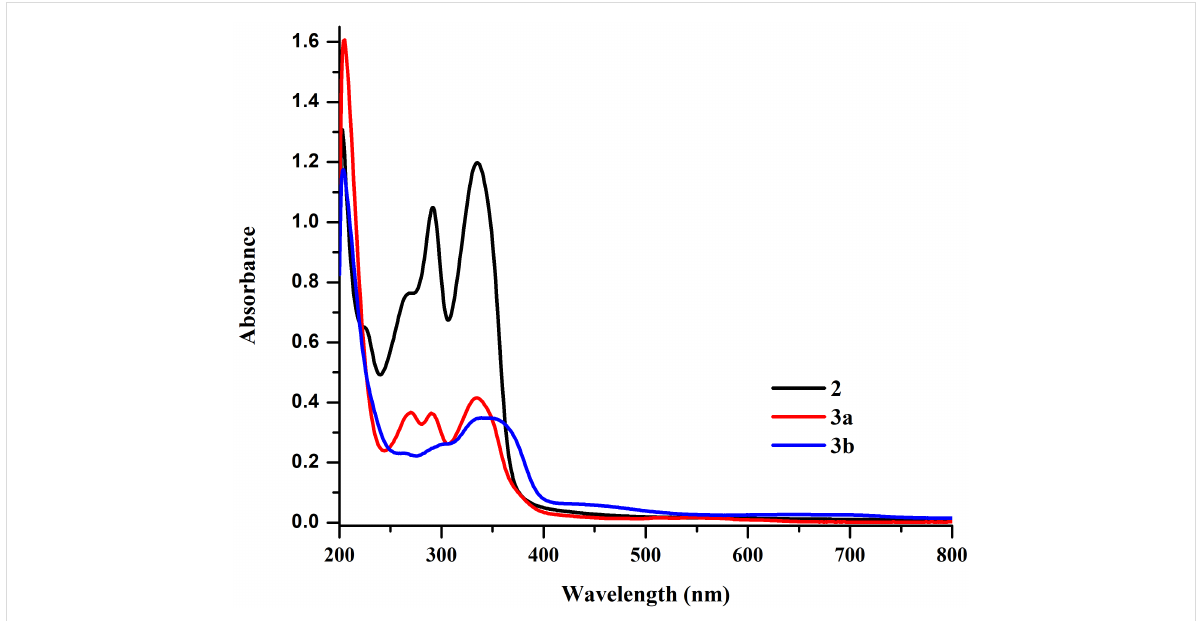
Figure 2: UV–vis spectra of the metalloligand 2 and heterometallic prismatic cages 3a and 3b in methanol (1.0 × 10 − 5 M) at 298 K.